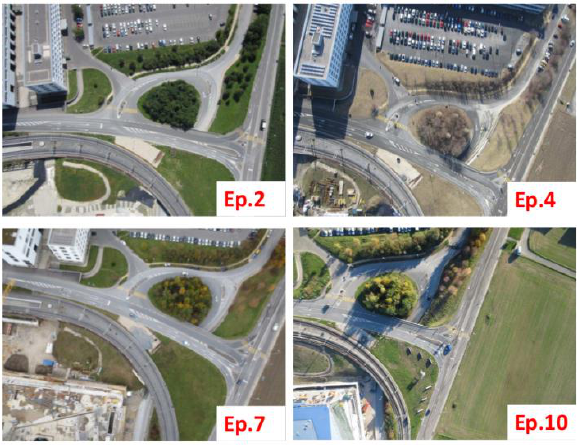
Figure 6. Example of a reference image selected in Epoch2